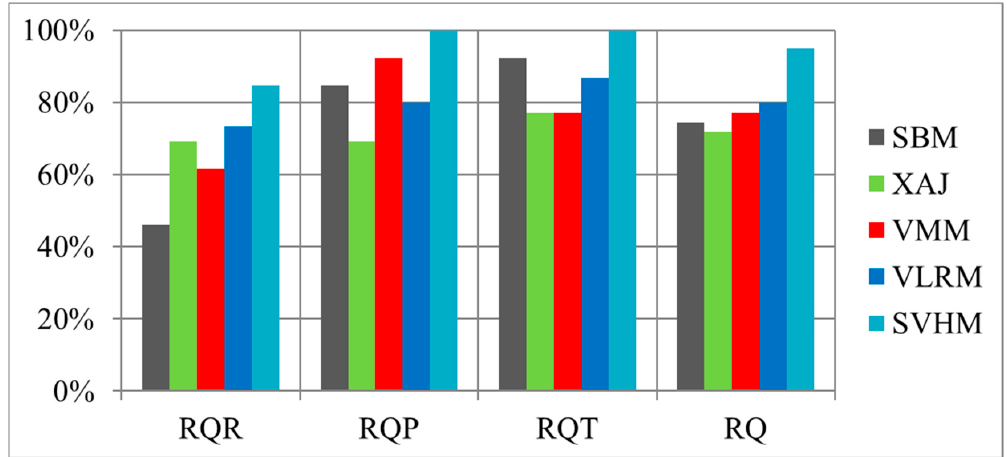
Figure 8. Comparisons of performance measures for different models in simulating all flood events in Zijingguan Basin (Note: RQR, RQP and RQT denote the ratio of qualified total runoff, ratio of qualified flood peak and ratio of qualified appearance time for flood peak, respectively. Qualified forecast results (RQ) is the mean of RQR, RQP and RQT. RQ can be classified by A grade: 85–100%, B grade: 70–85% and C grade: 60–70% [36] .